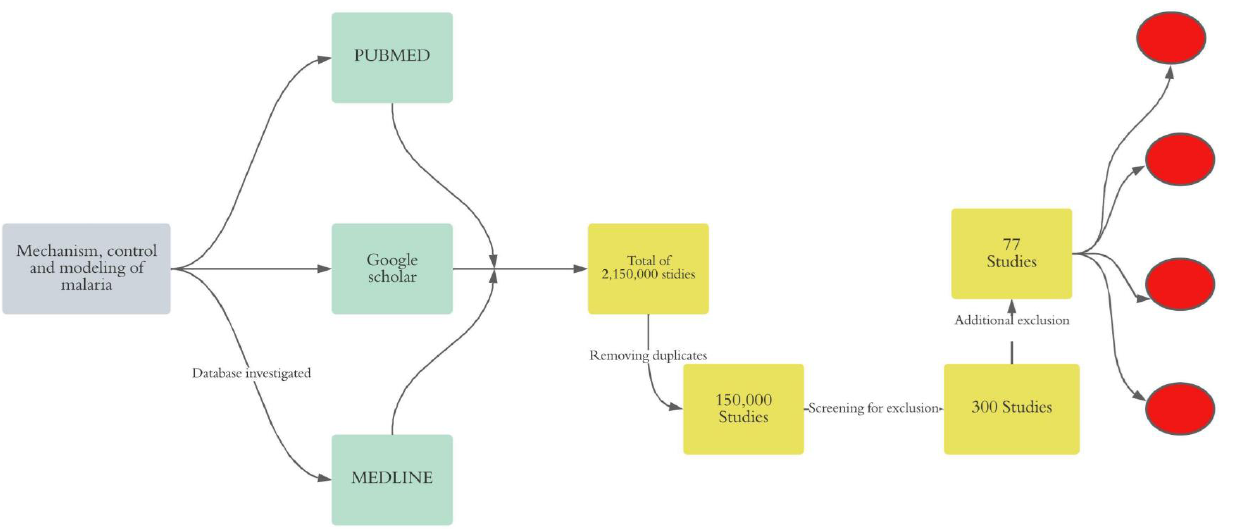
Figure 1. Synthesis of the method. In gray, the final objective of the review is shown, in green, the investigated databases are indicated, in yellow, the exclusion process is indicated, and in red, the clustering of the selected papers is shown.